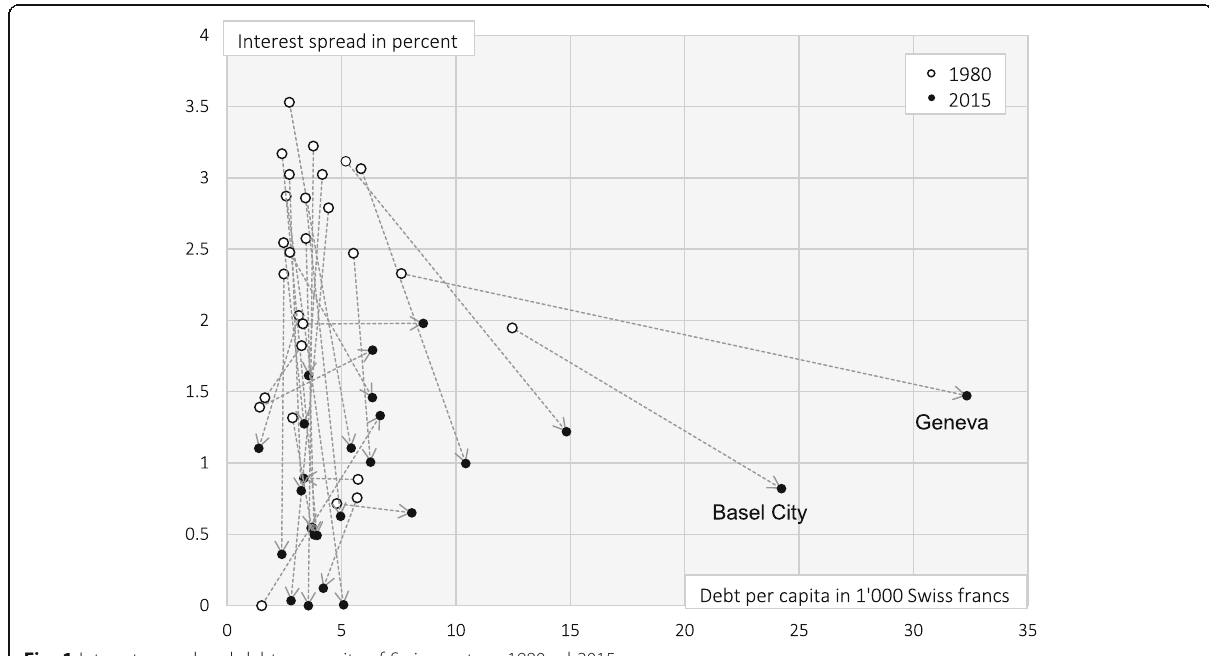
Fig. 1 Interest spread and debt per capita of Swiss cantons 1980 ad